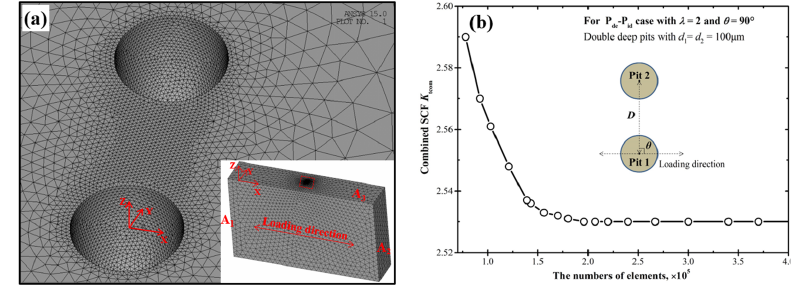
Figure 2. The results of finite element meshing and the convergence study. ( a ) The mesh refinement around the pits with the inset showing the whole model meshes; and ( b ) the convergence study with different numbers of elements.